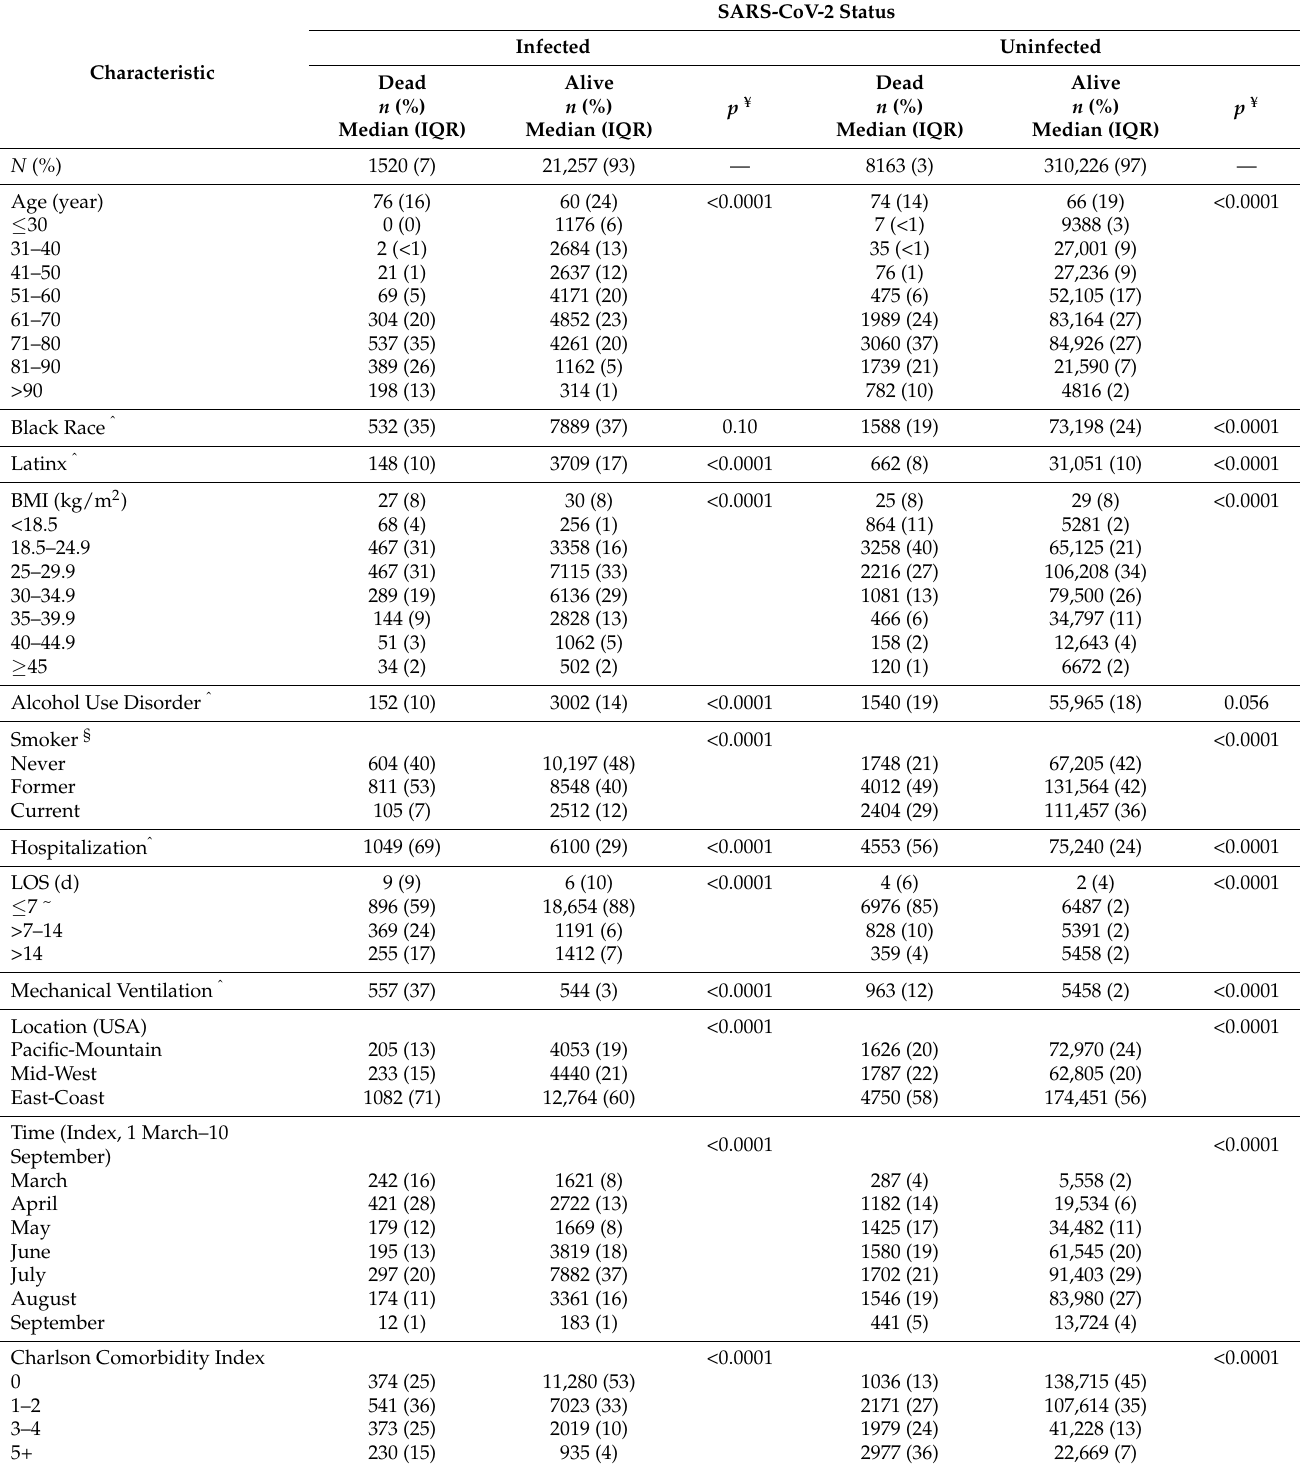
Table 1. Clinical Characteristics of the study population by SARS-CoV-2 infection status and 30-day mortality.